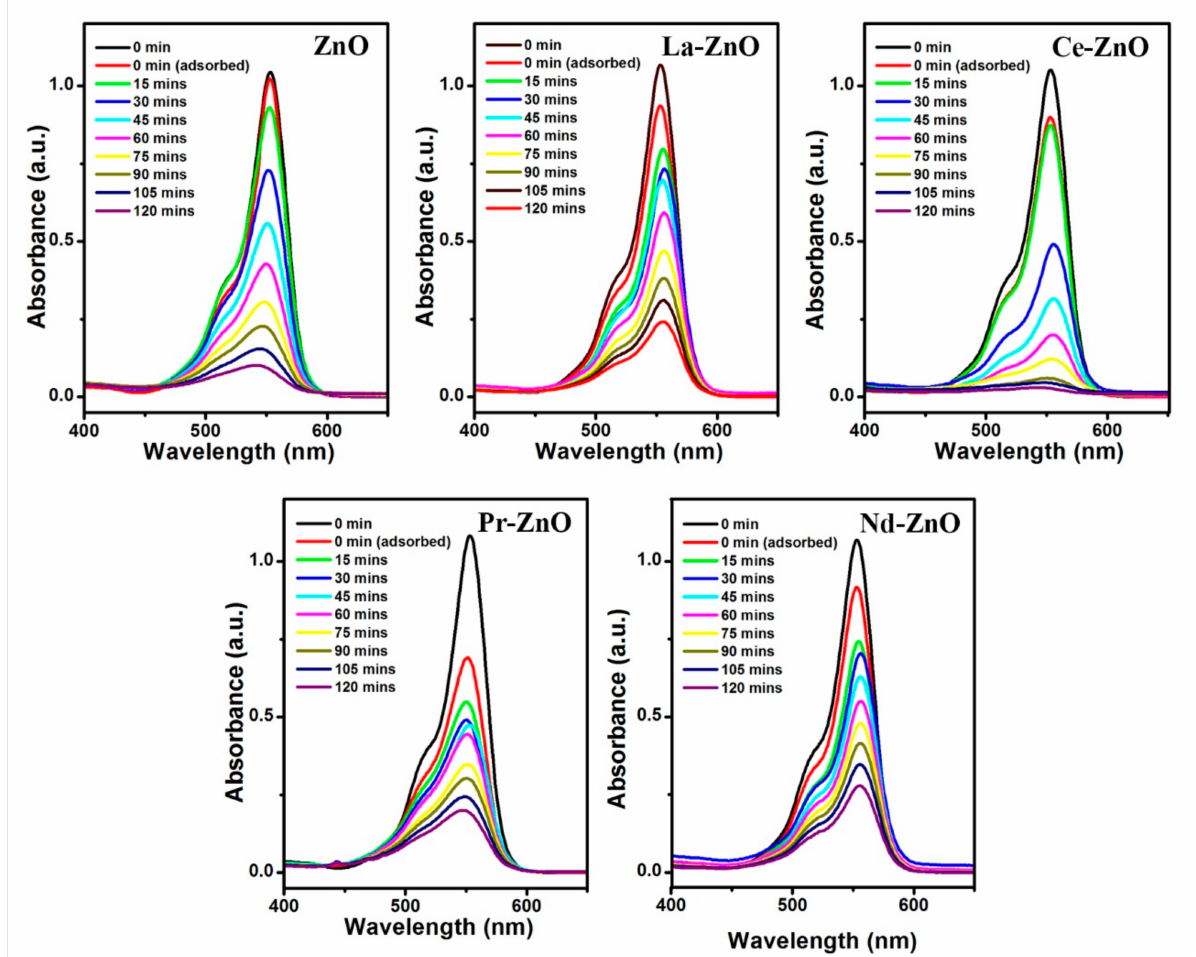
Figure 8. UV–Vis absorption spectra of the RhB dye in the reaction mixture as a function of time t in the presence of the photocatalysts under study and upon irradiation with UV light. Data are given for nanoparticles calcined to 700 ◦